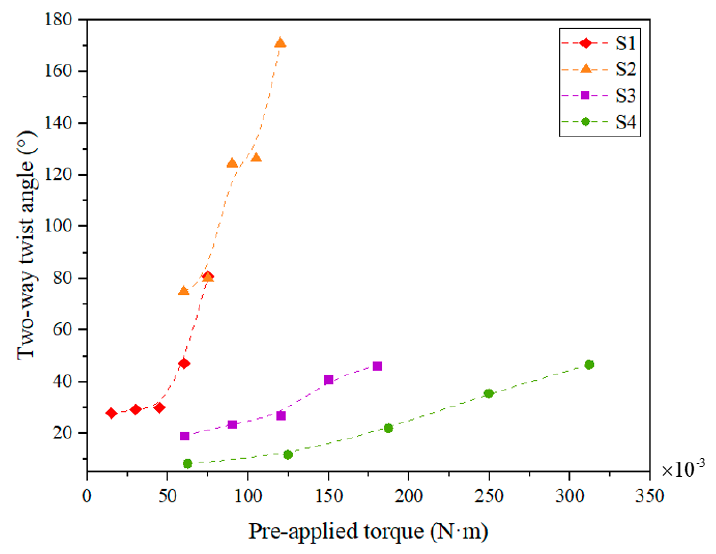
Figure 16. Two-way twist angle vs. the pre-applied torque.